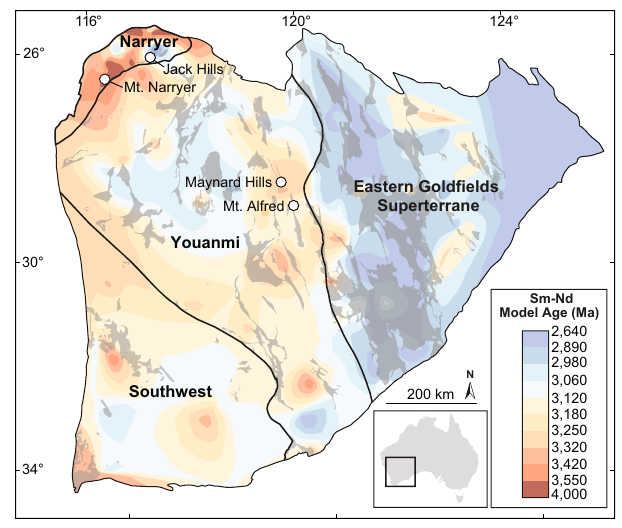
Fig. 1 Tectonic terrane map of the Yilgarn Craton, Western Australia. Main tectonic terranes are labelled and separated by thick black lines. Greenstone belts are shown in dark grey. Contoured Sm-Nd model ages from whole rock analyses are from ref. 21 . and highlight the distribution of ancient crust exposed in the Narryer Terrane and its possible continuation beneath younger sequences in the western part of the craton. White circles mark the location of ~3000 Ma sedimentary sequences containing Hadean and early Eoarchaean detrital